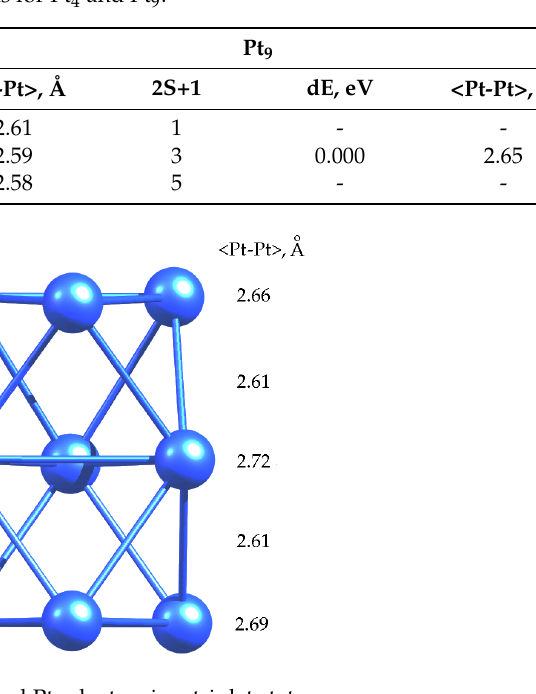
Figure 7. Optimized geometries of Pt 4 and Pt 9 clusters in a triplet state. Table 6. Results of geometry calculations for Pt 4 and Pt 9 . Table 7. Relative energies of Pt 4 *C 6 H 6 and the energy of BZ adsorption on Pt 4 for different